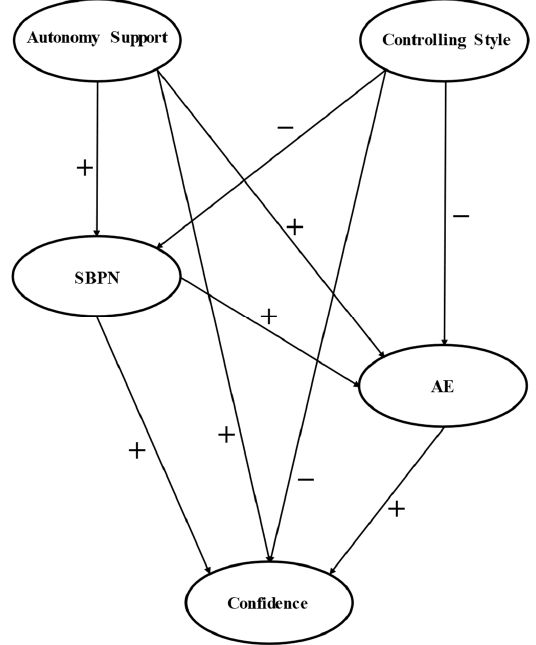
Figure 1. Hypothetical model with the expected relationships. Note: SBPNs = Satisfaction of basic psychological needs; AE = Academic engagement.